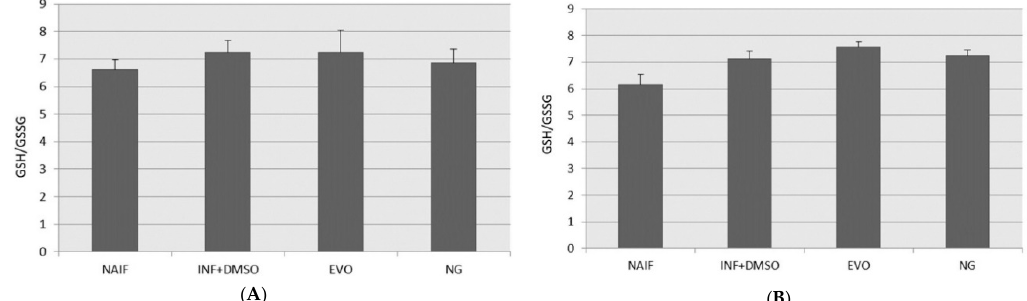
Figure 7. Reduced glutathione to oxidized glutathione (GSH/GSSG) ratio after treatment under the two experimental conditions: ( A ) SET1; ( B ) SET2.